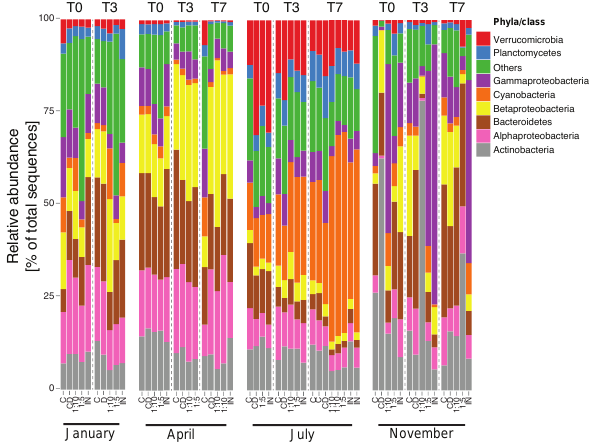
Figure 8. Relative abundances (i.e. percentage of total sequences) of major bacterial groups at phyla/class level in the different treat- ments and experiments. Colours denote specific